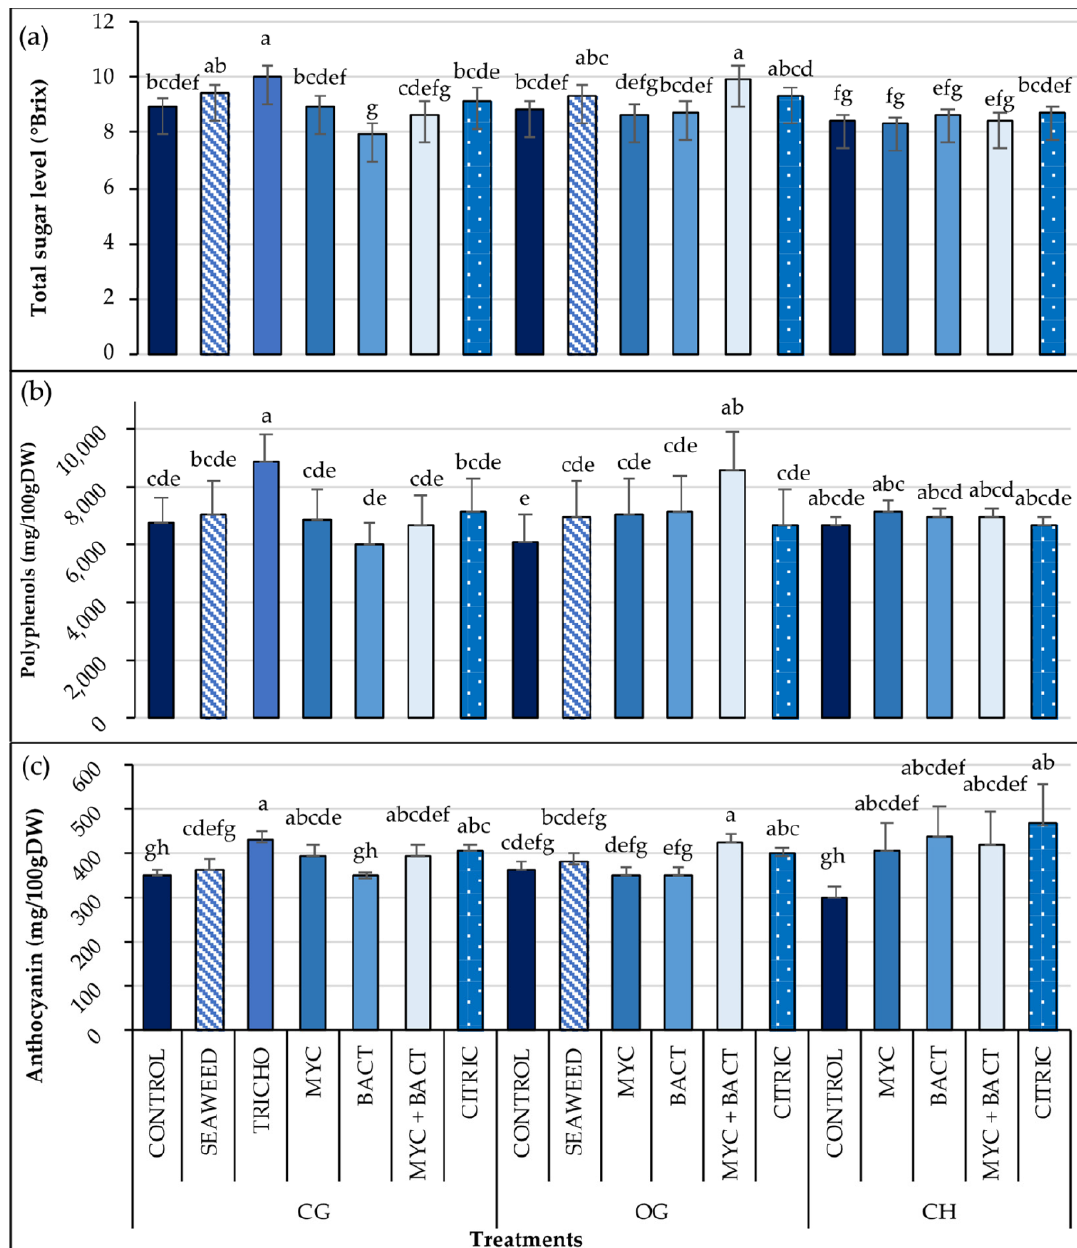
Figure 5. The influence of biostimulants and growing system on the total sugar level ( a ), total polyphenol content ( b ), and anthocyanin content ( c ) of berries harvested in winter and summer 2018. Means followed by the same letter are not significantly different ( p ≤ 0.05). CG: conventional greenhouse; OG: organic greenhouse; CH: conventional high tunnel; CONTROL: without biostimulant; three bacteria ( Azospirillum brasilense , Gluconacetobacter diazotrophicus , and Bacillus amyloliquefaciens